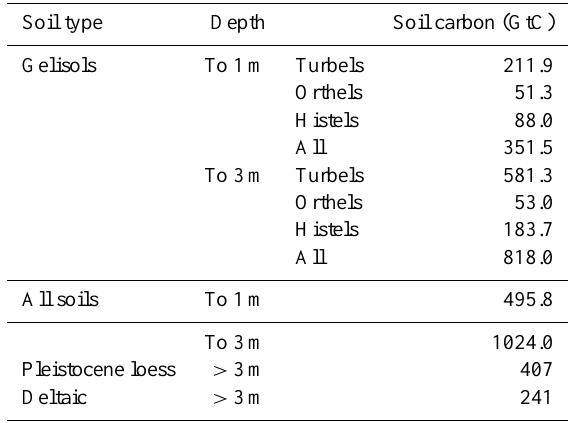
Table 6. Permafrost region soil carbon stock estimates from Tarnocai et al. (2009).